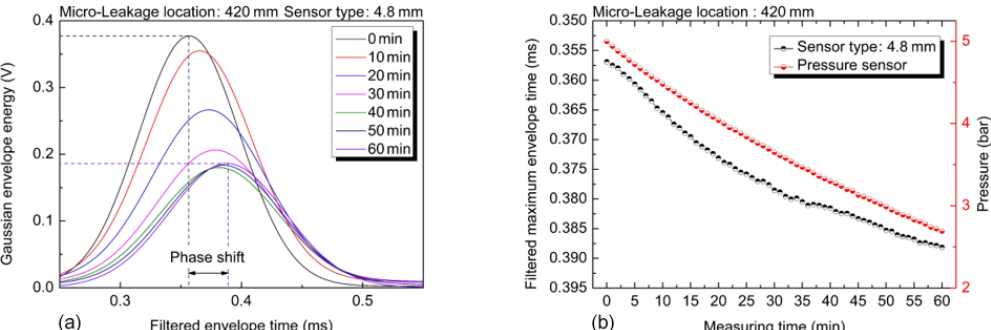
Figure 7. Phase shift of ultrasonic sensor envelope signal filtered through a Gaussian distribution for micro-leakage location of 420mm.